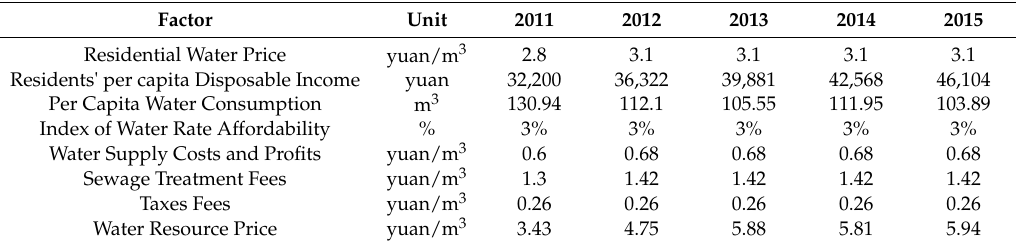
Table 3. Calculation of water resource price in Nanjing.